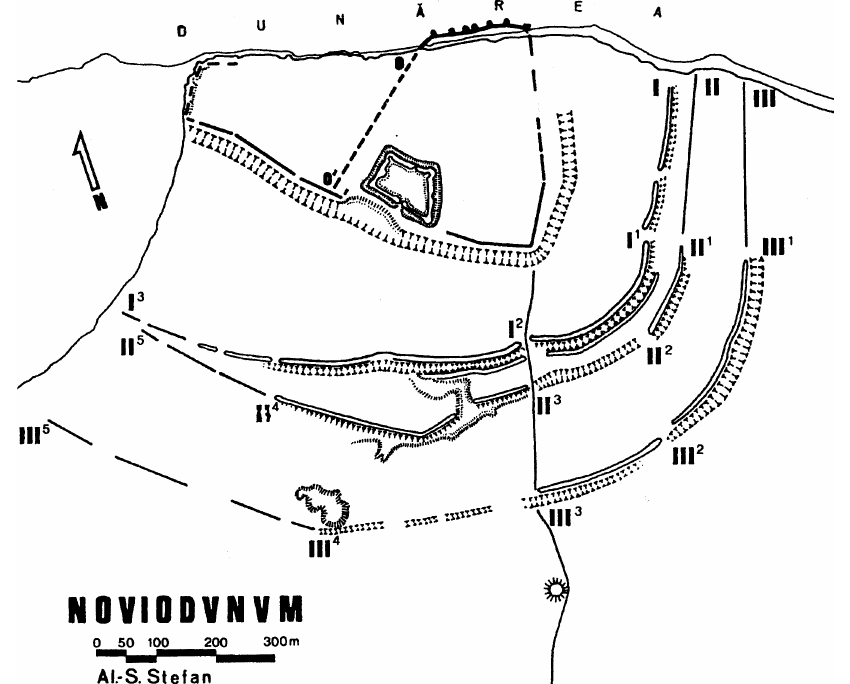
Figure 7 The western resistivity survey under way at Noviodunum, July 2002; River Danube beyond.